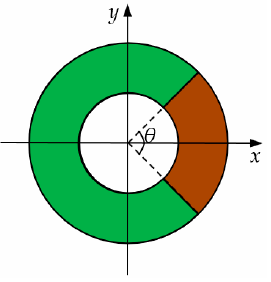
Figure 3. Schematic diagram of the secondary windings.